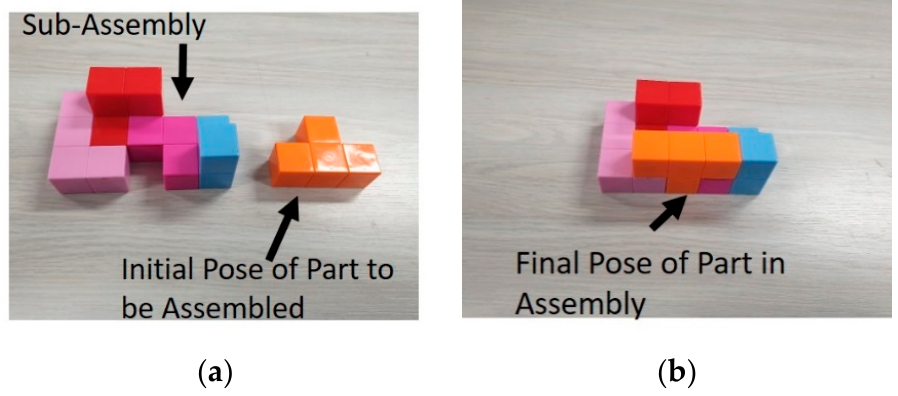
Figure 1. ( a ) The initial pose of the part (to be assembled) and sub-assembly are shown. ( b ) The final pose of the part in the assembly is shown. It can be seen that there is no feasible grasp to pick the part from its initial pose and move to its final pose without part